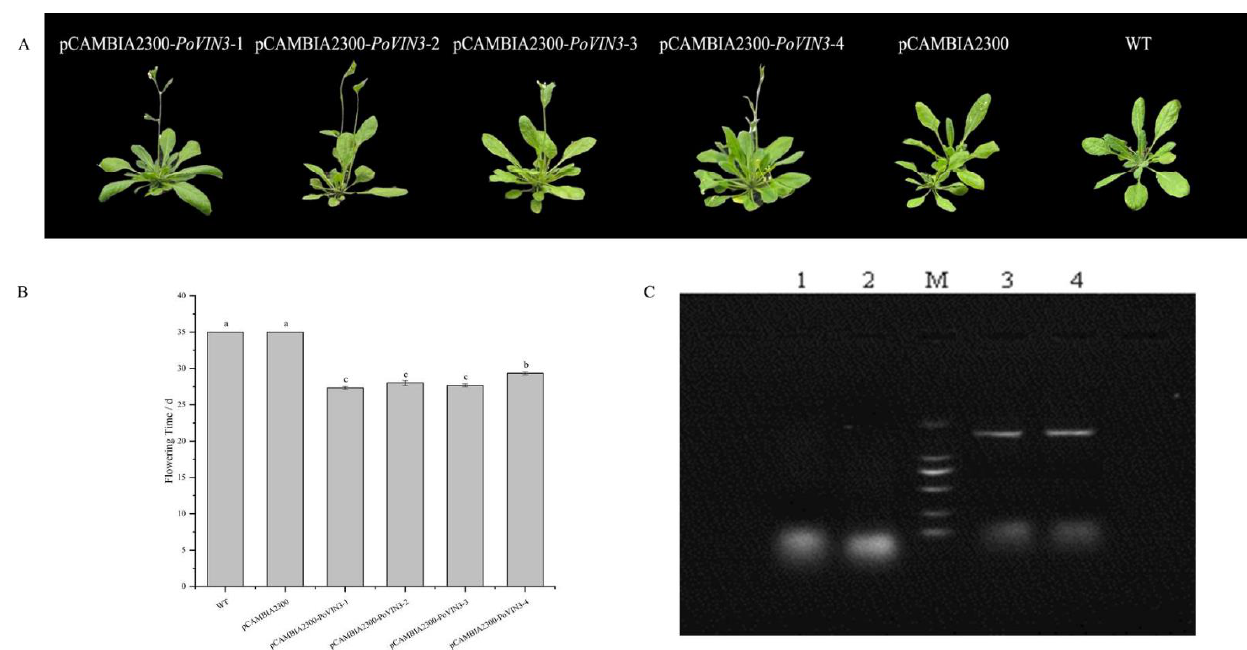
Figure 5. The phenotype and PCR amplification of Arabidopsis thaliana transformed with PoVIN3 . ( A ) The phenotypes of the 4 − week − old transgenic Arabidopsis thaliana and WT plants. ( B ) The flowering time of transgenic Arabidopsis thaliana and WT plants. The standard error (SE) is indicated by error bars. Different lowercase letters (a – c) indicate significant differences at p < 0.05. ( C ) PCR assay of PoVIN3 in WT (1), pCAMBIA2300 plants (2), overexpression Arabidopsis thaliana plants (3 – 4), and M means DNA maker DL2000.